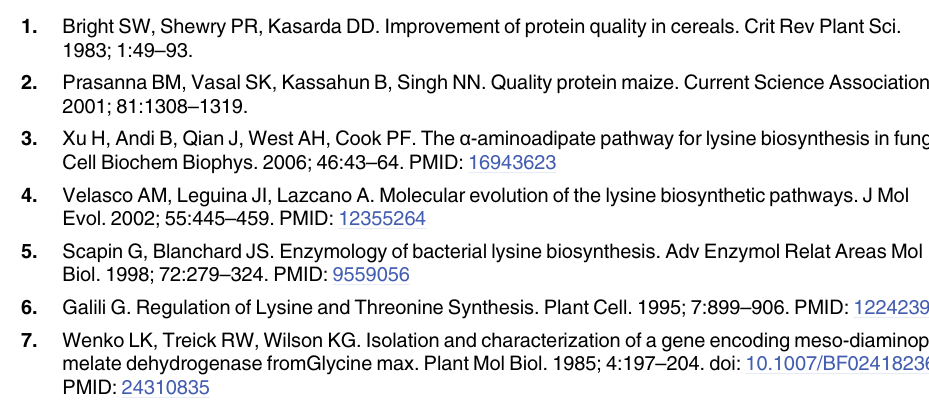
S3 Table. Table for the summary of the modules and coexpression gene number of LBPGs. S4 Table. Table for Coexpression relationship of Lysine biosynthesis pathway genes with elongation factors 1 α genes. S5 Table. Table for Coexpression relationship of Lysine biosynthesis pathway genes with ribosomal protein genes. S6 Table. Table for LBPGs coexpression transcription factor. S7 Table. Table for down regulated differentially expressed (DEGs) genes (which were DHDPS1 coexpressed genes) with O2 Binding Site in their promoter region. S8 Table. Table for The DEGs coexpressed with DHDPS. S9 Table. Table for The source of Data underlying the findings described in our manu-